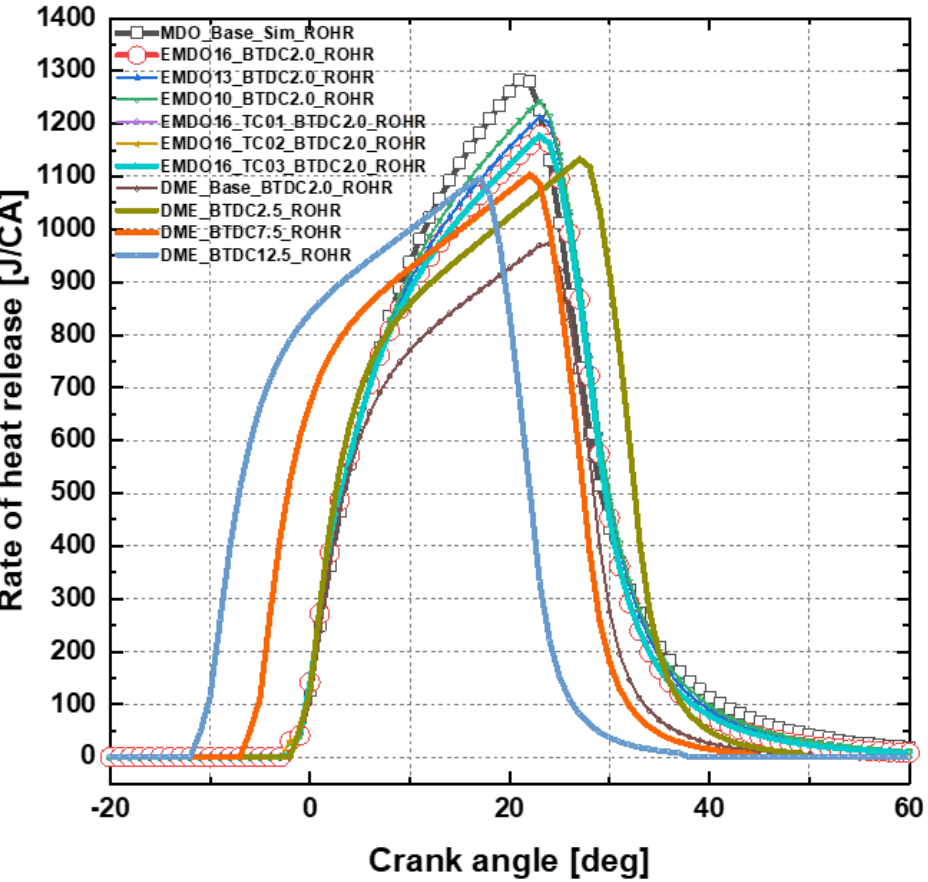
Figure 4. Rate of heat release in accordance with MDO, EMDO, and DME fuels for 100% engine loads.